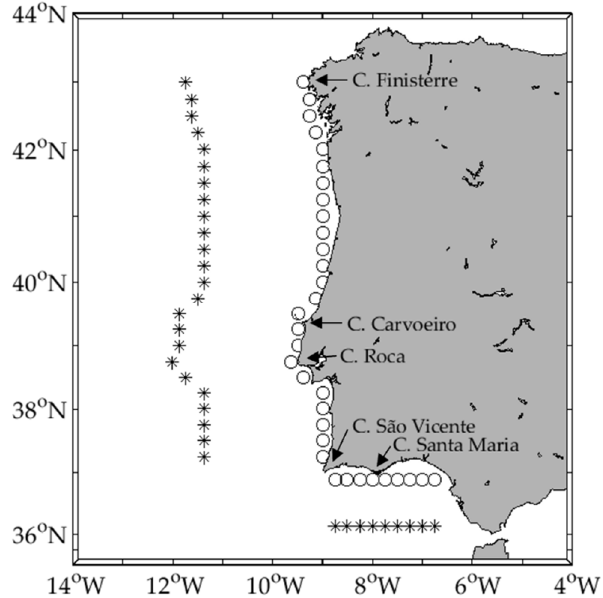
Figure 1. Map of the study area. The circles represent the nearshore points where both wind and SST data were obtained. The asterisks represent the offshore points where SST data were obtained.